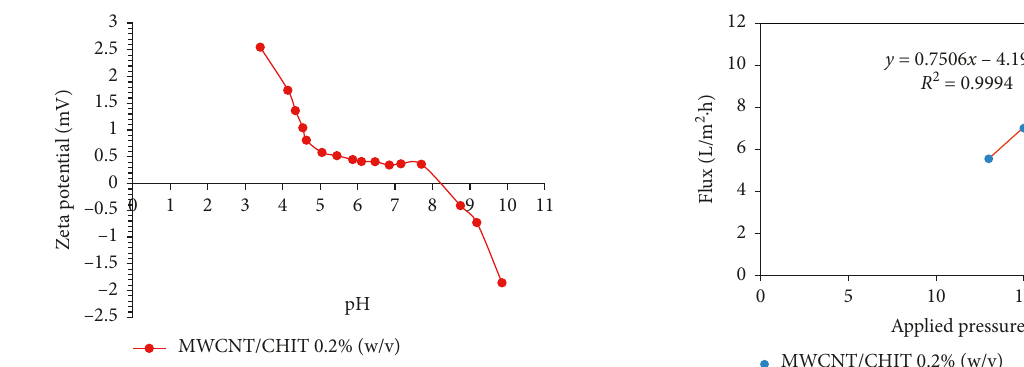
Figure 5: Zeta potential of MWCNT/CHIT evaporative cast membrane.